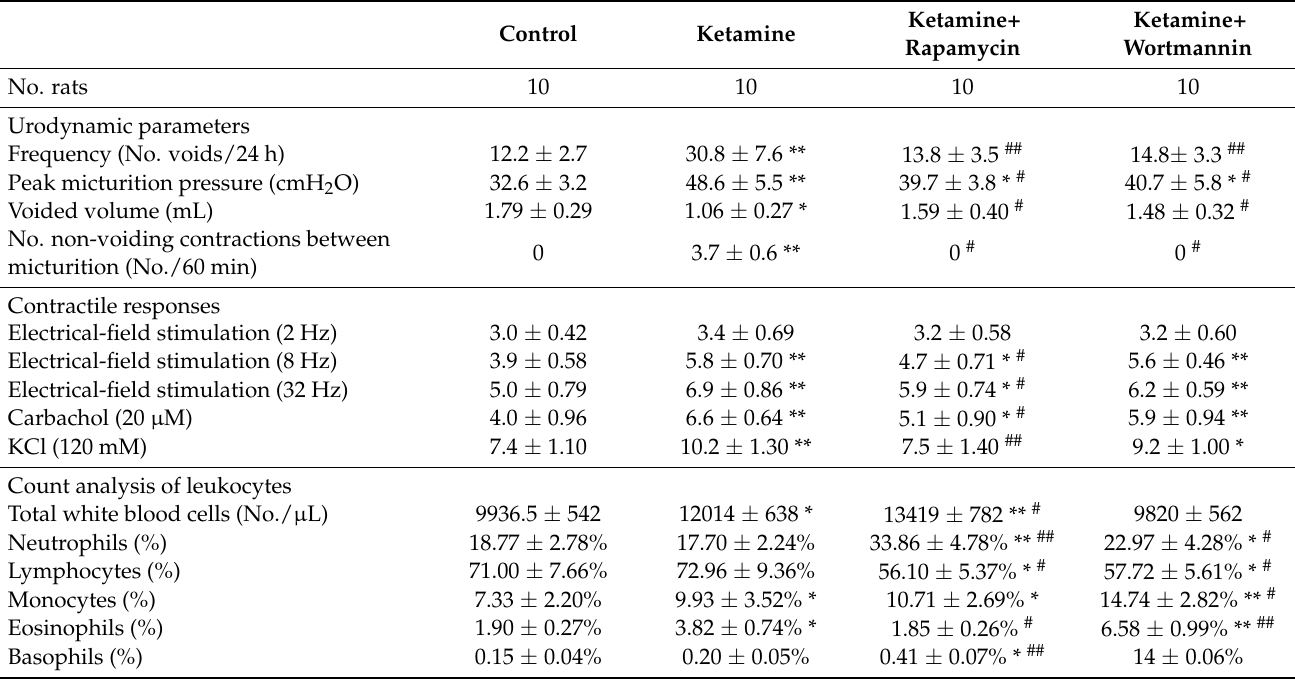
Table 2. Urodynamic parameters, contractile responses, and count analysis of leukocytes for different experimental